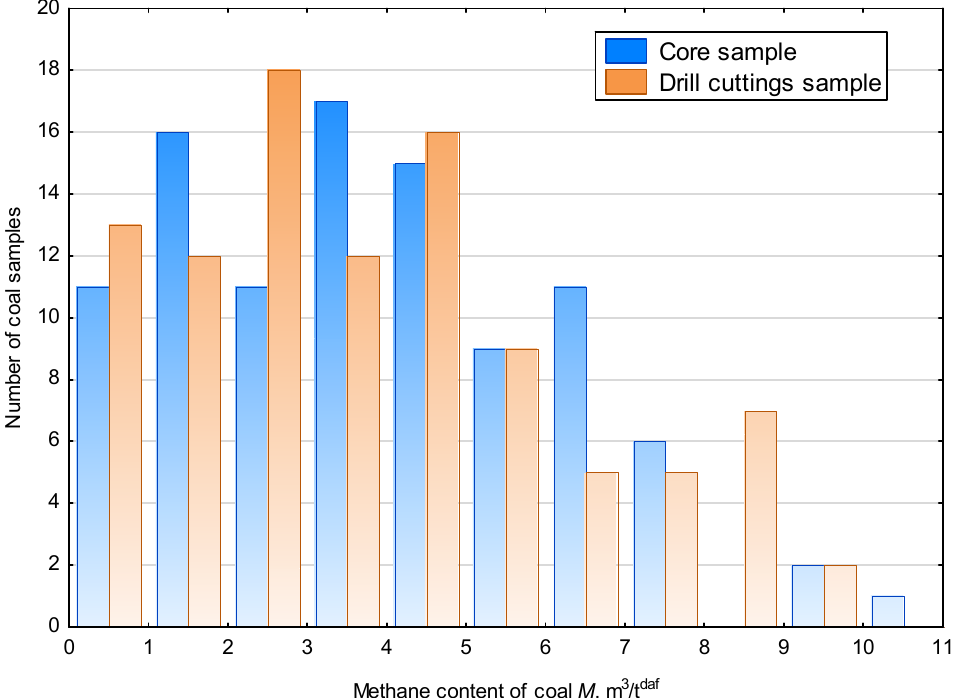
Figure 5. Variation of methane content of coal in particular seams (n is the number of coal samples pairs in a coal seam).